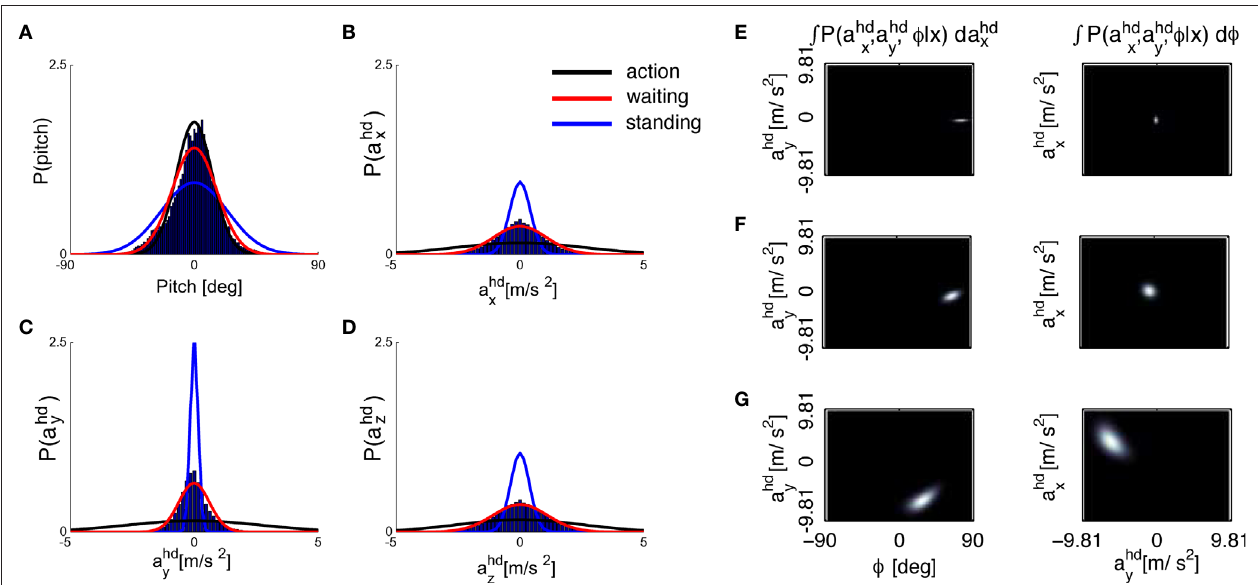
FIGURE 4 | Estimated probabilities from the recorded head movements and the resulting posteriors. (A) Histogram for the pitch rotations in the casual condition as calculated with a parametrization of the fi tted rotation matrices according to a Fick-gimbal convention and Gaussian fi ts obtained by minimizing